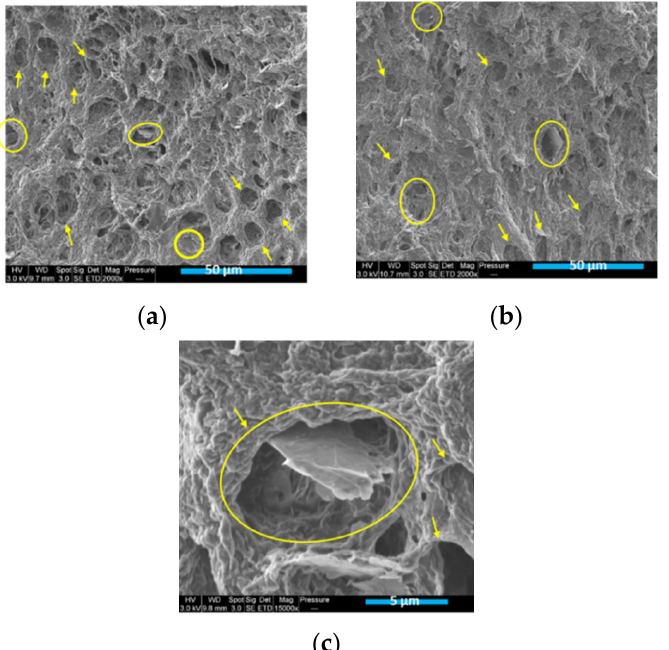
Figure 7. ( a , c ) SEM images of toluene-etched, injection-moulded PLA/PCL/10 wt.% M5 composite;